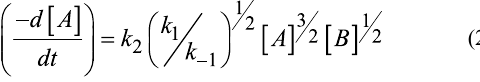
characteristic signal of the dimer 2a (q, 5.18 ppm). The values found were plotted in Figure 4 and a linear relationship between